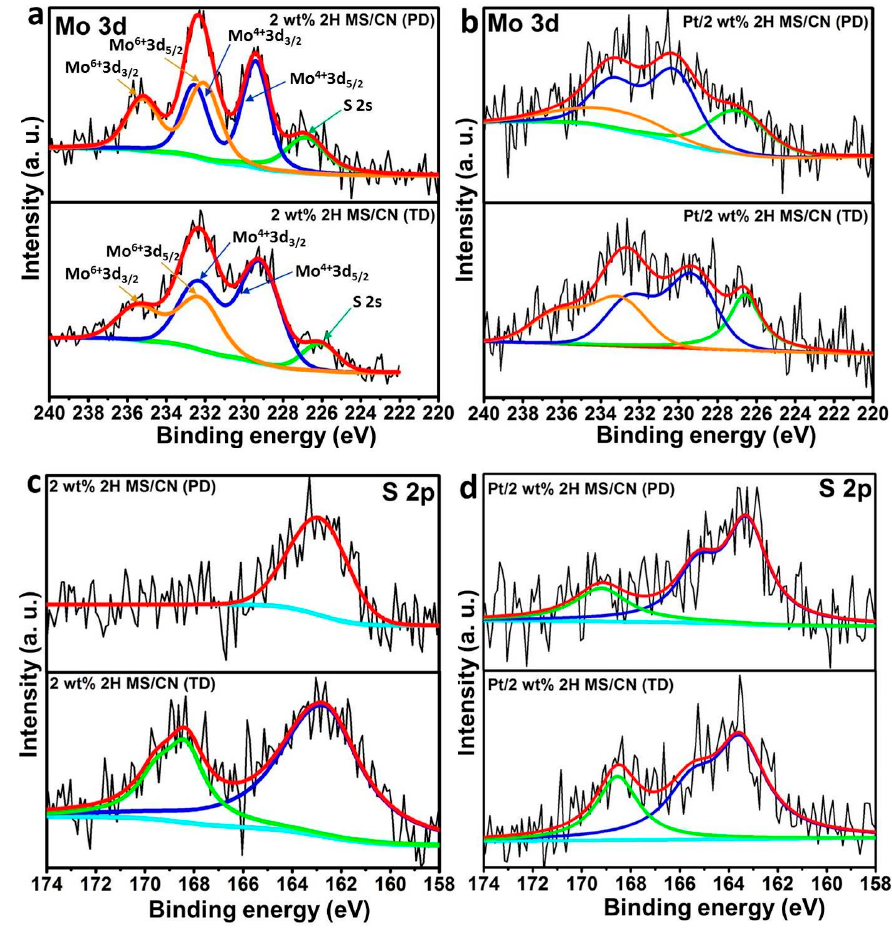
Figure 5. XP spectra of 2H MS-CN (PD) and 2H MS-CN (TD) in the Mo 3d and S 2p region before ( a , c ) and after 6h of reaction ( b , d ).